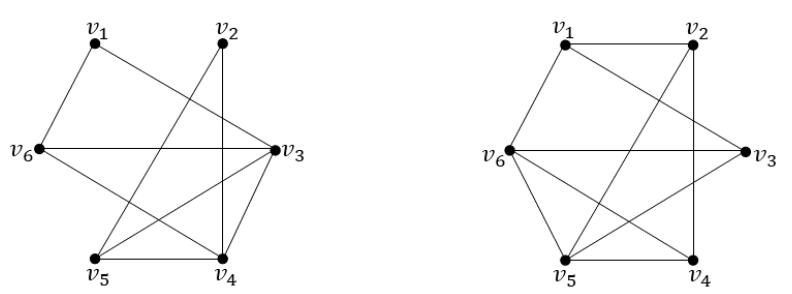
Figure 7. The graph H and its δ -complement H δ